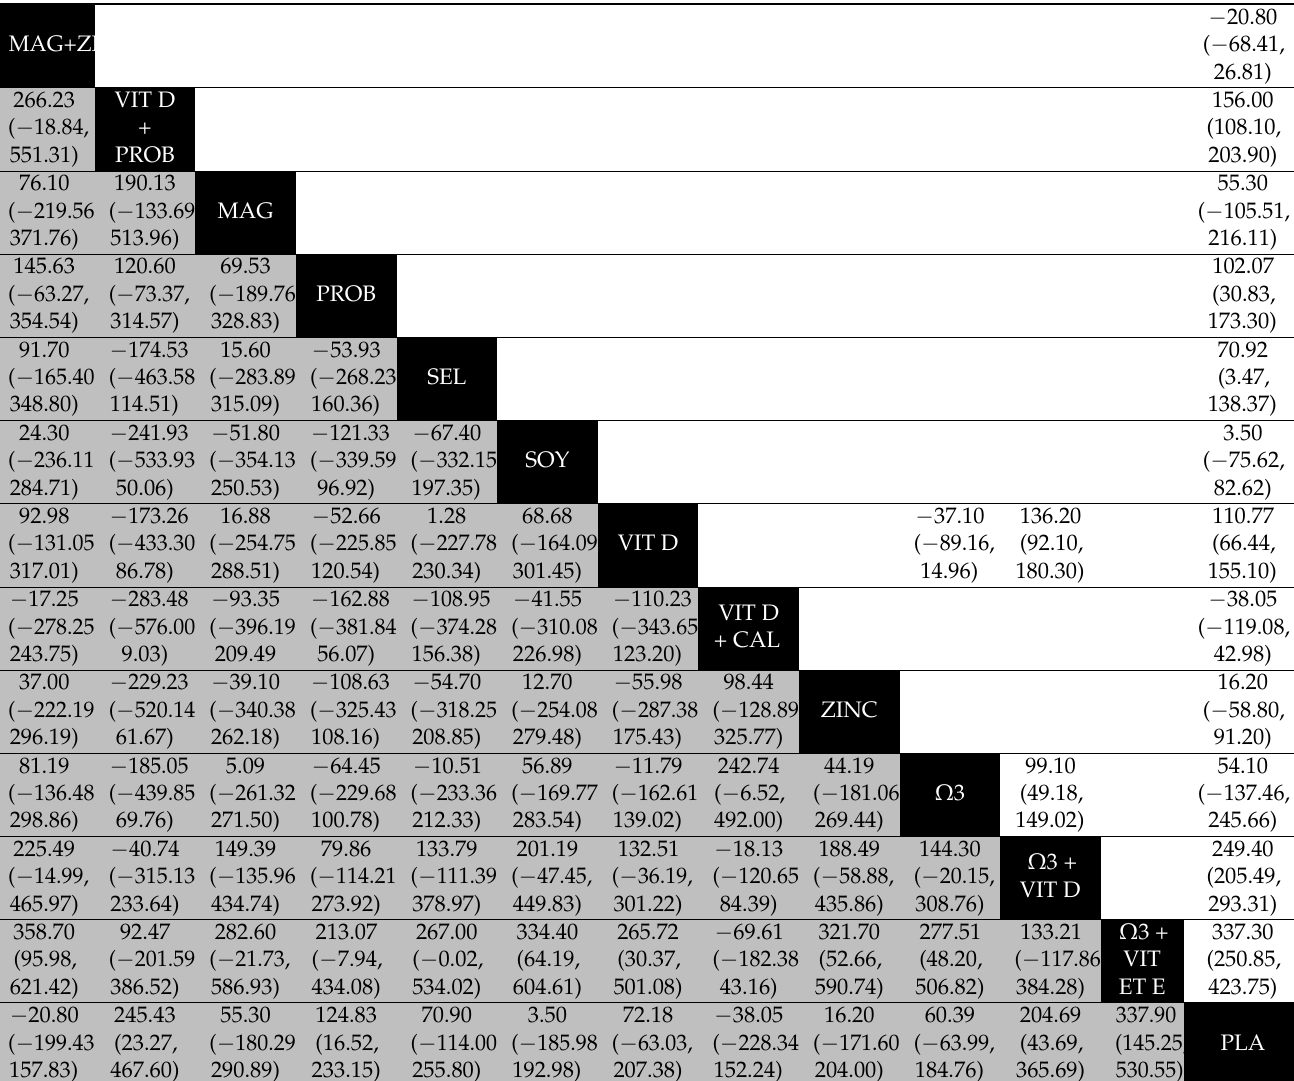
Table 5. Direct and indirect (in grey) estimates of the mean difference of TAC. Each column presents a different